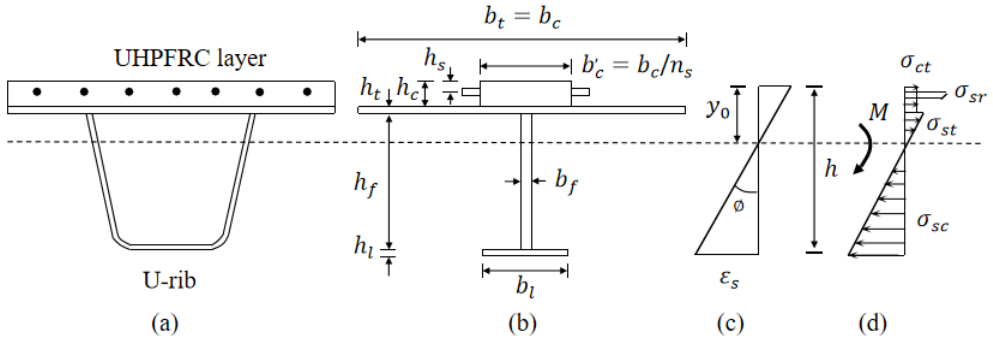
Figure 16. Stress diagram of ultimate bearing capacity calculation. ( a ) Original section ( b ) Equivalent section ( c ) Distribution of strain ( d ) Stress.